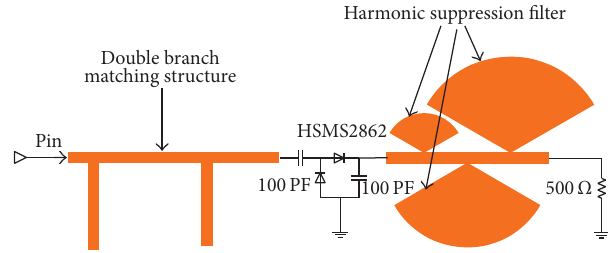
Figure 3: The layout of double branch structure cascaded with rectification circuit and fan-shaped filtering structure.